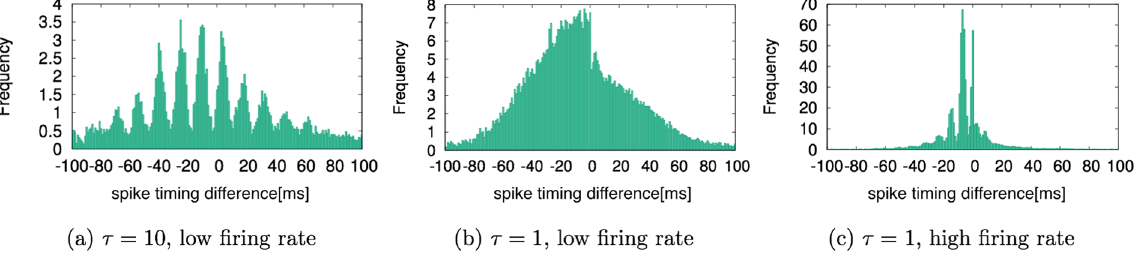
Figure 6. Frequency distributions of spike-timing differences between presynaptic and postsynaptic neurons when ( a ) τ = 10, ( b ) τ = 1 during a low firing rate and ( c ) τ = 1 during a high firing rate. The horizontal axis represents difference in spike-timing. The vertical axis represents frequency.